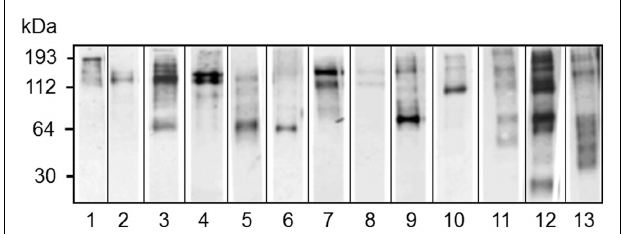
FIGURE 10 |Truncated Sp185/333 proteins are present in the coelomic fluid. Enlarged regions of three different two dimensionalWestern blots of coelomic fluid proteins from the same sea urchin were analyzed with different anti-Sp185/333 sera; anti-66, anti-68, or anti-71. Anti-66 recognizes AHAQRDFNERRGKENDTER from element 1; anti-68 recognizes GGRRGDGEEETDAAQQIGDGLC from element 7; anti-71 recognizes TEEGSPRRDGQRRPYGNR from element 25 (see Figure 6A for element positions). Decreasing numbers of spots in blots analyzed with antisera that recognize peptides in more C-terminal regions of the proteins suggests that many are either truncated or have missense sequence toward the C-terminus. Reprinted from Dheilly et al. (2009) with permission from the American Association of Immunologists, Inc., copyright 2009.